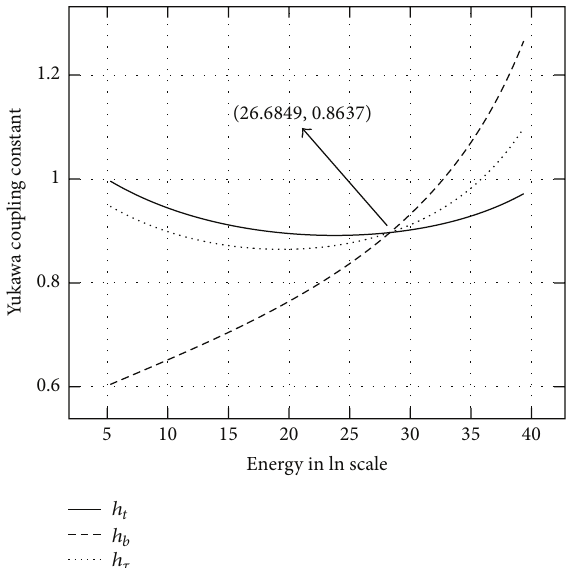
Figure 1: Third-generation Yukawa couplings unification for 𝑚 𝑠 = = 173 . 5 GeV, (𝑒 26 . 6849 = 3 . 8828 × 10 11 ) GeV. 𝑚 𝑡